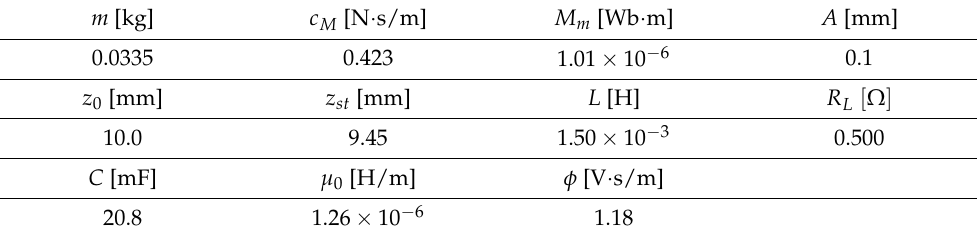
Figure 4. Schematic diagram of the experimental setup. Table 1. Parameter values used in experiments.